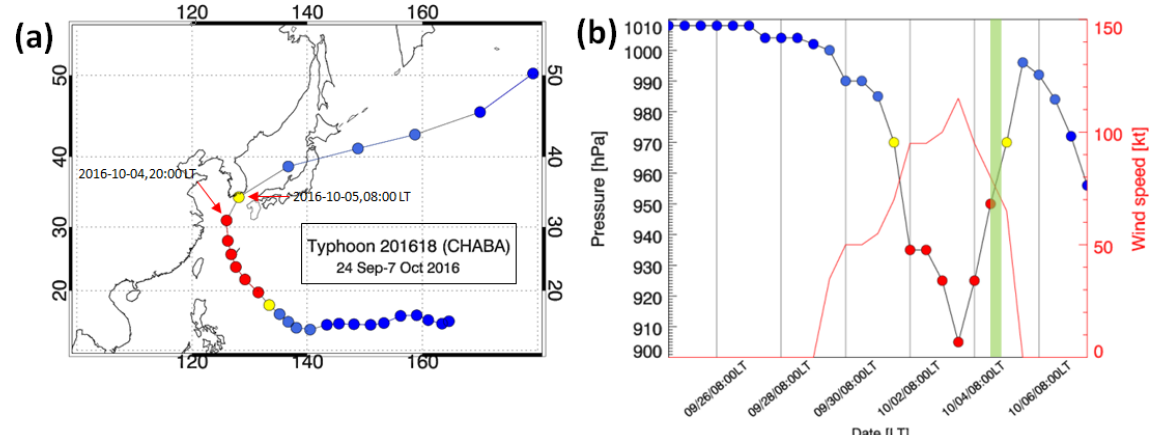
Figure 2. (a) The track of Typhoon Chaba is denoted by dots from 24 September to 7 October 2016 every 12h (date format: year-month- day, hour). (b) Central pressure of Typhoon Chaba corresponding to the tracks in (a) (date format: month/day/hour). The red line denotes the maximum sustained wind speed. The green shadow band denotes the time of ground-based airglow observation from 20:00 to 04:00LT during the night of 4–5 October